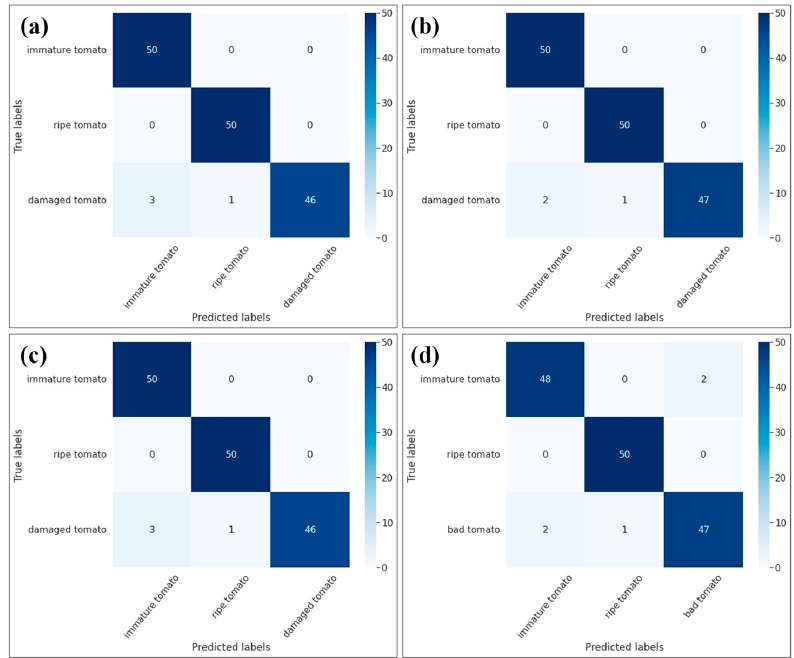
Figure 2. Confusion matrices for ( a ) standalone Yolov5m model, ( b ) Yolov5 with ResNet-50, ( c ) Yolov5 with ResNet-101, and ( d ) Yolov5 with Efficient-B0.